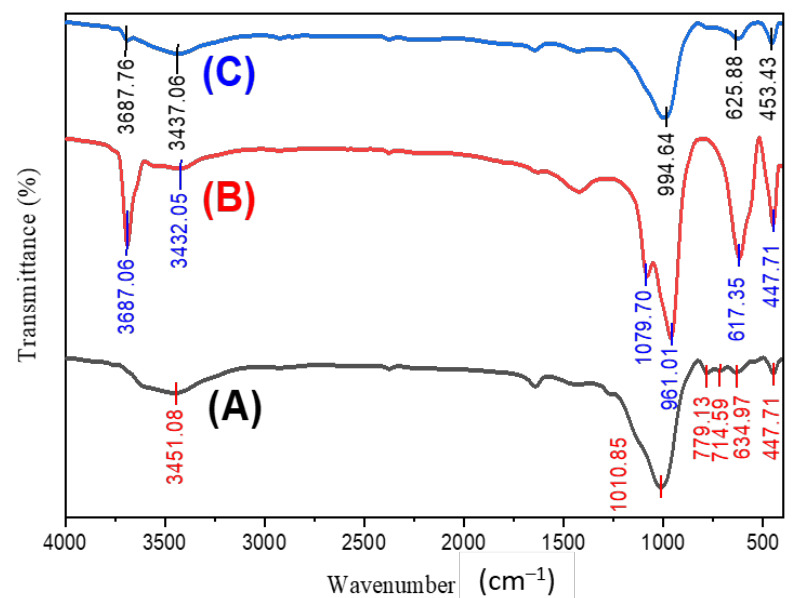
Figure 2. FTIR charts of hydrothermally prepared zeolite ( A ), serpentine ( B ), and Zeo/Serp (2:1) nanocomposite ( C ).